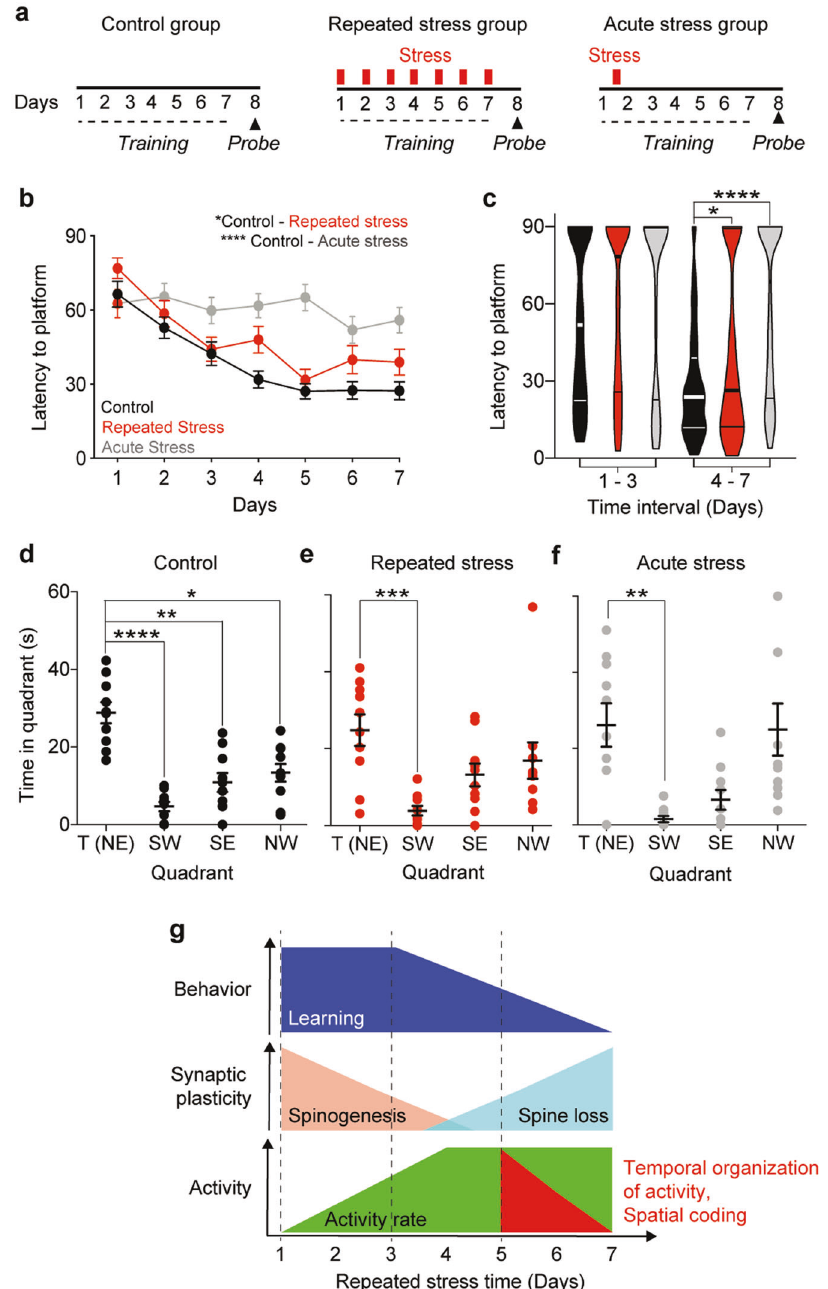
Fig. 5 Repeated and acute stress exposure impair learning and recall of a spatial memory task. a Experimental timeline for Morris water maze training (dashed lines) and testing (triangles, probe) of Control, Repeated or Acute stress mice groups. b Repeated stress during training and acute stress on the fi rst training day, increased latency to reach the hidden platform ( p CA < 0.0001 and p CR = 0.045 l; n = 40 per time point; Repeated Measurements ANOVA). Circles: average latency of 10 (4 trials each) mice. Black, Control; red, Repeated; gray, Acute stress groups. c Latencies of Repeated (red) and Acute (gray) stress groups differed signi fi cantly from the ones of the Control (black) group on days 4 – 7 ( p CA_1 – 3 = 0.56 and p CR_1 – 3 = 0.91; p CA_4 – 7 < 0.0001 and p CR_4 – 7 = 0.034; n 1 – 3 = 120 per group, n 4 – 7 = 160 per group). Violin plots: median and quartiles of the distributions of latencies pooled over days 1 – 3 or 4 – 7 for Control (black), Repeated (red) or Acute (gray) stress groups. d Control mice spent signi fi cantly more time in the target quadrant (NE), during the probe trial ( p SW < 0.0001, p SE = 0.004, p NW = 0.036; n = 10 animals per quadrant). e Mice stressed repeatedly during training spent signi fi cantly less time only in the quadrant opposite to the target quadrant during probe trial ( p SW = 0.002, p SE = 0.29, p NW = 0.68; n = 10 animals per quadrant). f Mice stressed acutely on the fi rst training day spent signi fi cantly less time only in the quadrant opposite to the target quadrant during probe trial ( p SW = 0.003, p SE = 0.87, p NW > 0.999 ; n = 10 animals per quadrant). Circles: time per quadrant per mouse. Black, Control; red, Repeated and gray, Acute stress groups. Horizontal lines: means ± s.e.m. c – f Kruskal – Wallis test, p -values adjusted after Dunn ’ s corrections for multiple comparisons. g Summary and temporal sequence of stress-induced impairments in dCA1 PNs connectivity and activity patterns as well as